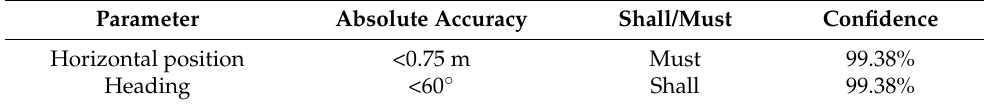
Table 4. Performance requirements for the process “global